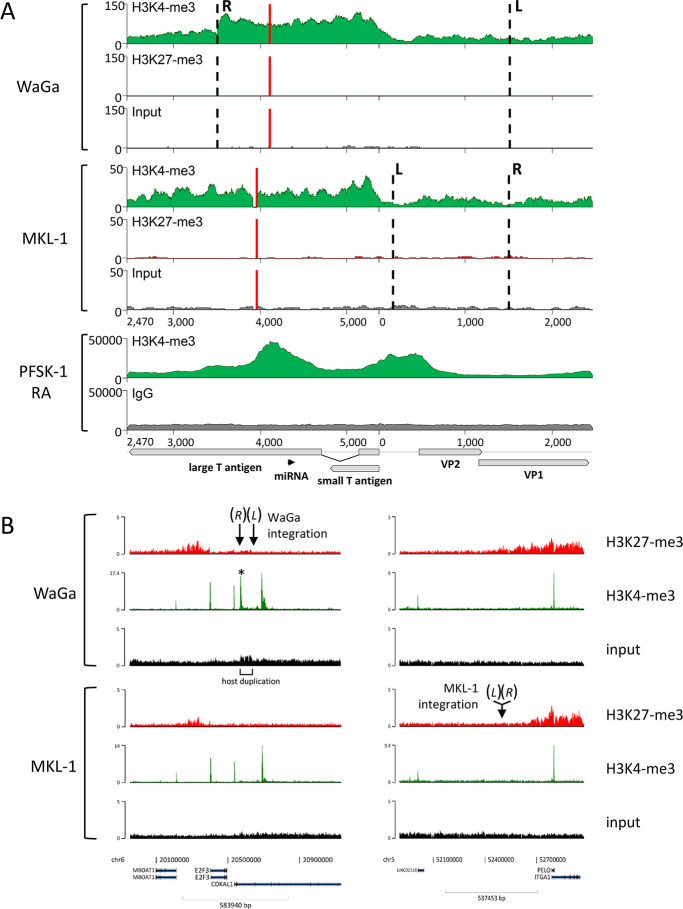
Histone modification pattern in MKL-1 and WaGa cells.(A): Coverage of the activating histone mark H3K4-me3 and the repressive histone mark H3K27-me3 on integrated MCPyV obtained by ChIP-Seq of WaGa and MKL-1 cells (upper two panels). Dashed lines represent breakpoints into the host genome, red lines the truncating event in LT. In the lowest panel H3K4-me3 ChIP-Seq data from a replication assay (RA) performed in PFSK-1 cells that were published before [37] are included for comparison. Note: The viral reference genome JN707599 is presented starting with nucleotide 2,470 for better visualization of ChIP-Seq patterns located at the viral promoters (see annotation of X-axis). (B): ChIP-Seq data for H3K4-me3 and H3K27-me3 from WaGa (upper panel) and MKL-1 cells (lower panel). The left and the right panel represent the two host genomic regions (1mbp) of the WaGa (left) and MKL-1 (right) integration sites. The corresponding junctions (L and R, marked by arrows) are indicated. The asterisk marks an additional H3K4-me3 signal which is not present in MKL-1. The signal is located within the 66kbp host duplication and flanks junction R. It originates from the H3K4-me3 signal of the early region of the integrated MCPyV genome that harbors the right breakpoint (R, see A) and extends into the host chromatin. Host duplication in WaGa is visible by the marked enhanced ChIP input signal.